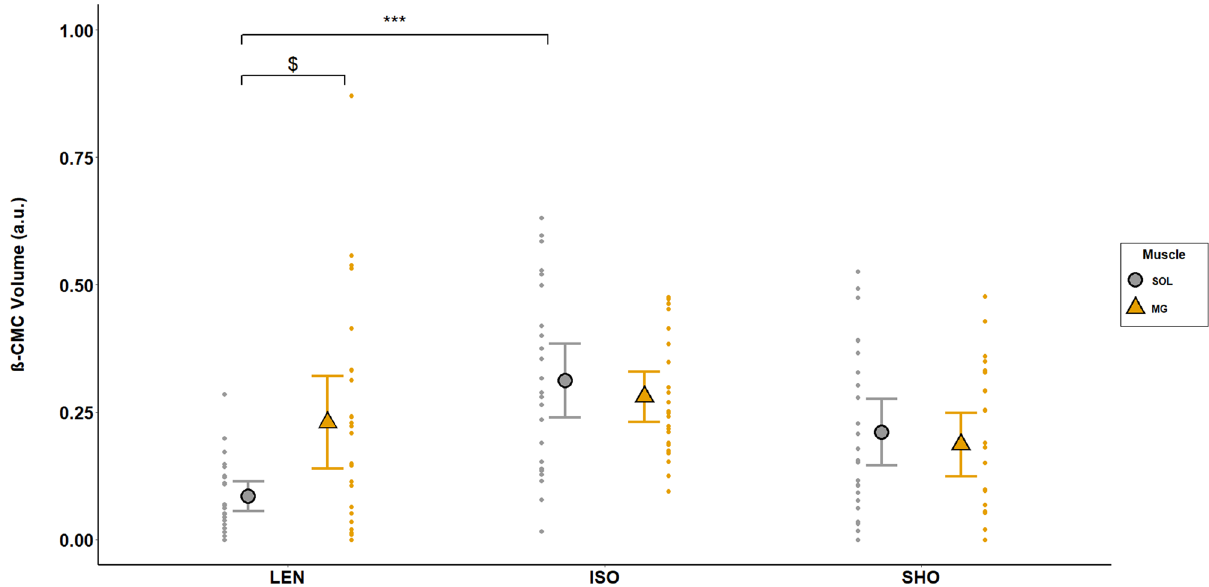
Figure 4. Effects of muscle contraction type and muscle type on beta-band CMC. CMC was computed as the volume in the beta-band (13–32 Hz) during the last 200 ms prior to the neurostimulation onset. Modulations are shown in the soleus (grey circles) and the medialis gastrocnemius (yellow triangles) during lengthening (LEN), isometric (ISO) and shortening (SHO) contractions. Error bars represent the 95% CI of the mean (n = 25). Lengthening vs isometric in SOL: ***p < 0.001; SOL vs MG during lengthening: $ p < 0.01.